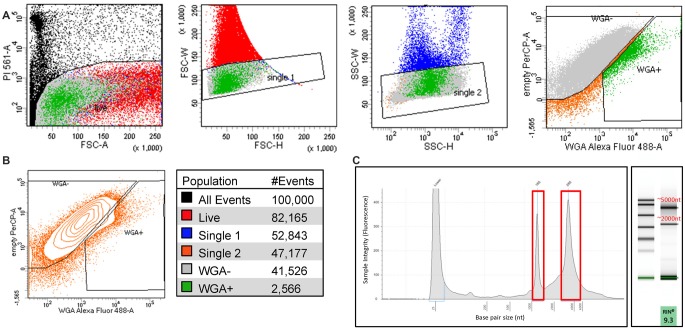
Isolating sensory neurons. (A) Fluorescence-activated cell sorting (FACS) purification of cultured DRG cells based on PI staining (dead) single-cell populations by forward scatter (FSC), single-cell populations by side scatter (SSC), and cells fluorescently labeled with WGA-488 (WGA+). (B) Contour plot of single WGA+ cells that were sorted directly into lysis buffer for RNA extraction and color scheme for the gated populations, each condition N = 5; ~3,000 cells. (C) Representative image of RIN values run on an Agilent TapeStation before RNAseq.